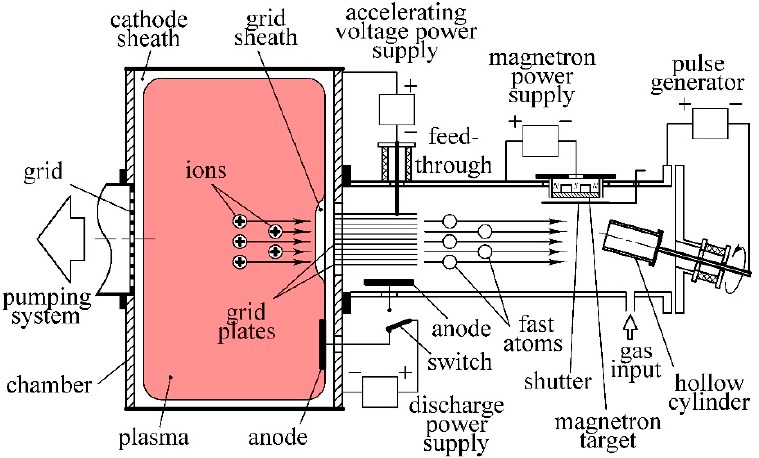
Figure 1. Schematic of experimental setup for the combined processing of complex-shaped parts. The wall of the cylindrical chamber has a rectangular, 31-cm-wide, and 7-cm-high hole, covered by an accelerating grid composed of 11 plane-parallel 0.5-mm-thick, 300-mm-wide, and 150-mm-long titanium plates. Plates with 5.5-mm-thick inserts between them are fastened together with tie rods. The accelerating grid is attached to the chamber walls using four ceramic insulators protected from deposition of metal films by hollow cylindrical screens (Figure 2).